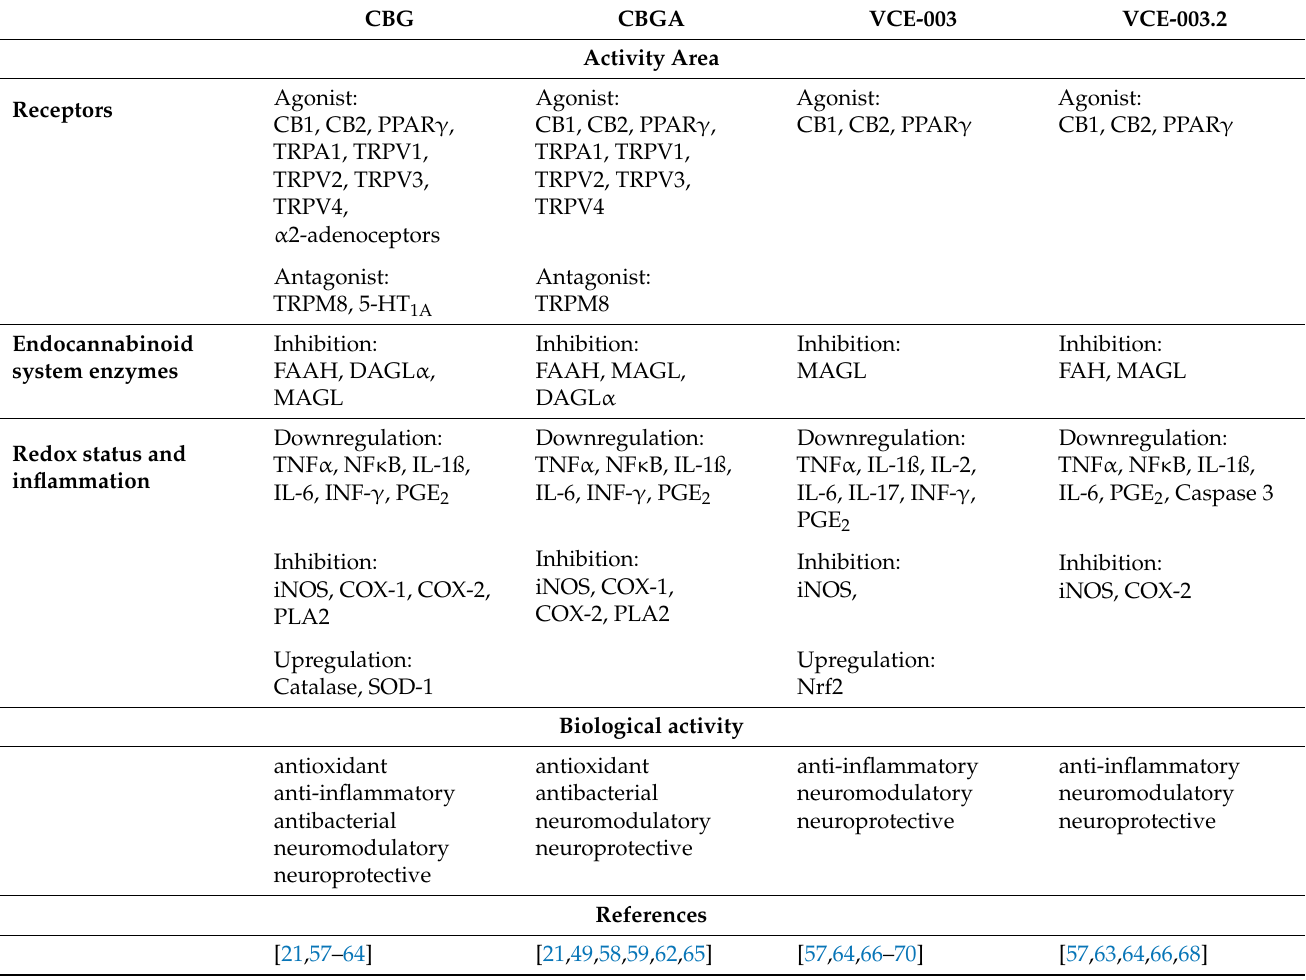
Table 1. Biological activity of CBG and its